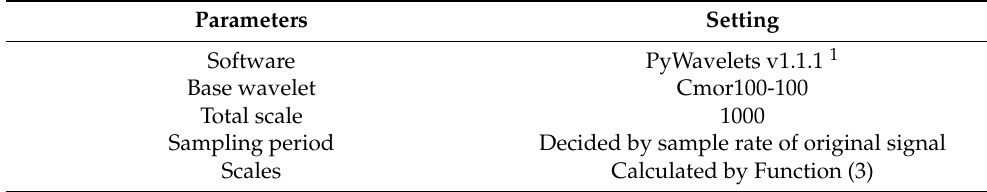
Table 3. Parameters of